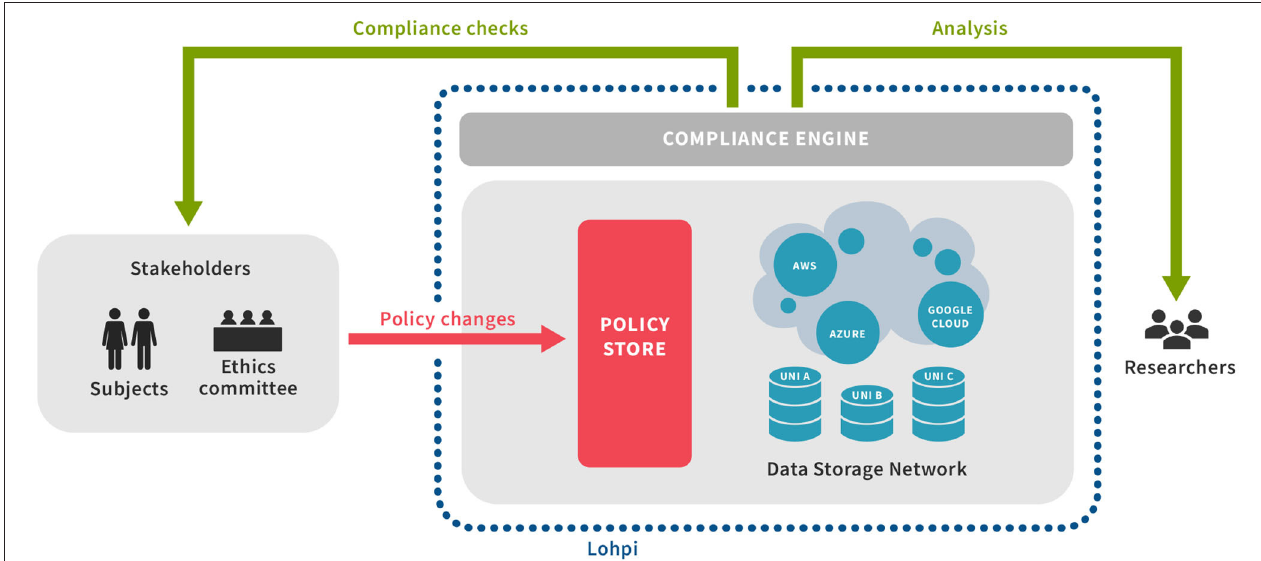
FIGURE 2 | Overview of Lohpi and interaction with Ethics committee and